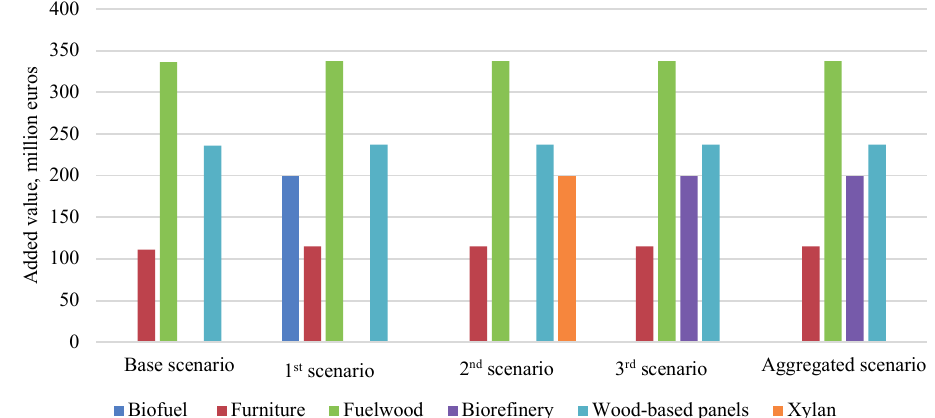
Fig. 7. Results of scenario analysis for new technologies in the forestry sector in Latvia, the year 2030.